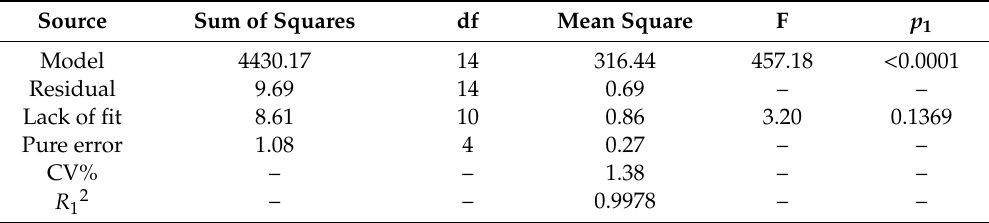
Table 3. The variance analysis of the fitted quadratic polynomial prediction model of Y . Source